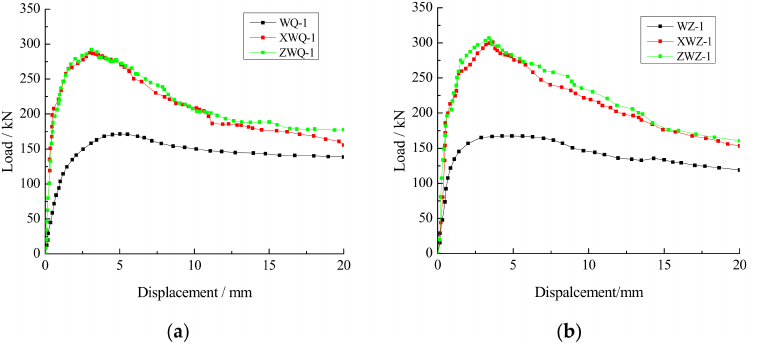
Figure 16. Load–displacement curves: ( a ) common brick masonry walls; ( b ) autoclaved fly-ash-brick masonry walls.